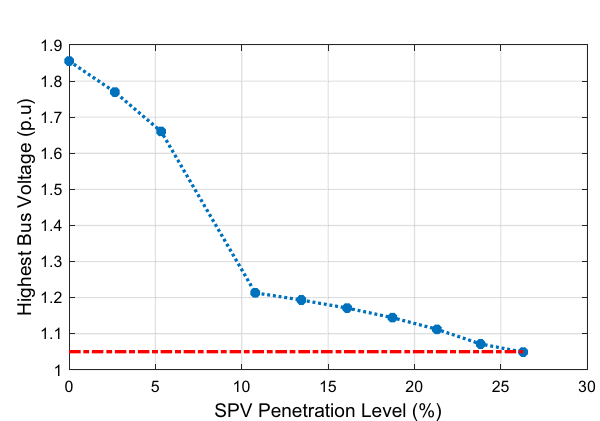
Figure 8. Impact of increasing SPV penetration on highest bus